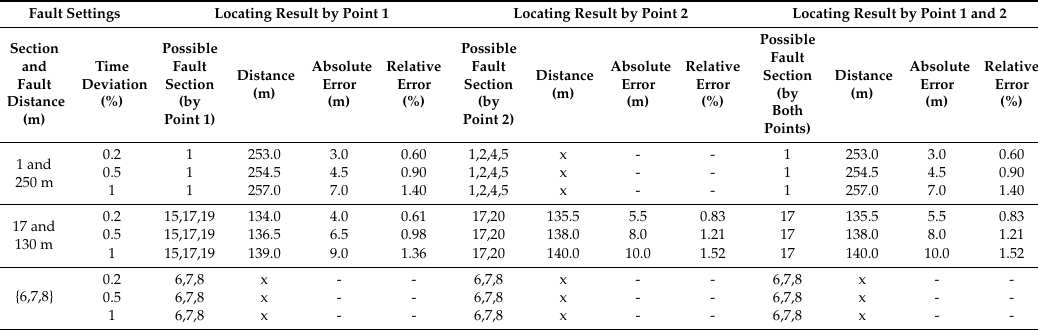
Table 8. Simulation results under di ff erent time deviations.